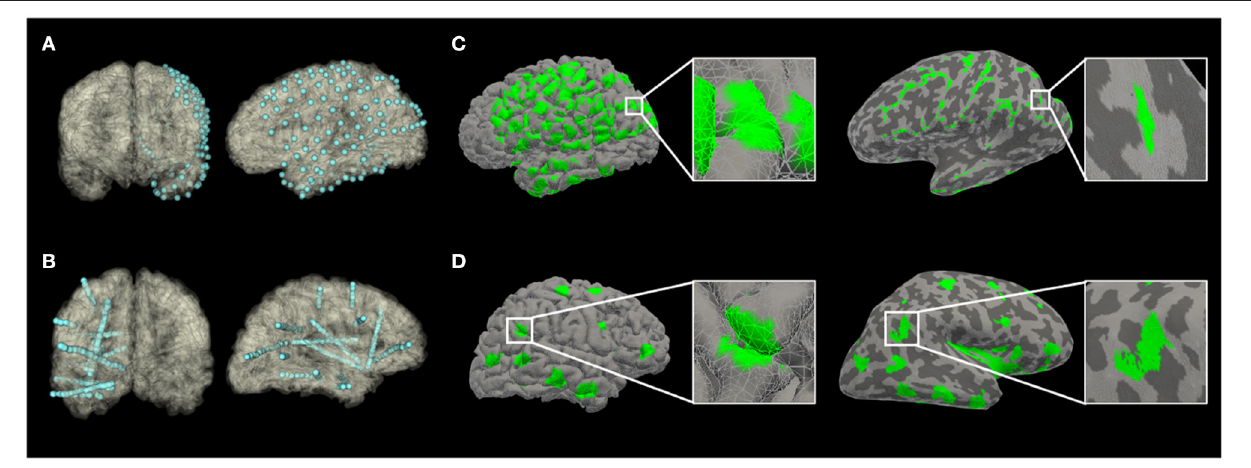
FIGURE 1 | The recording volume of gray matter covered by implants, projected to an anatomical pial surface (A,C) or an inflated pial surface (B,D) of subjects in Pair 1 ( A,B from Subject S1; C,D from Subject G1). On the inflated pial surface images, the lighter areas represent the gray matter over the convexity (crest of gyrus); while the darker areas represent the gray matter within sulci.